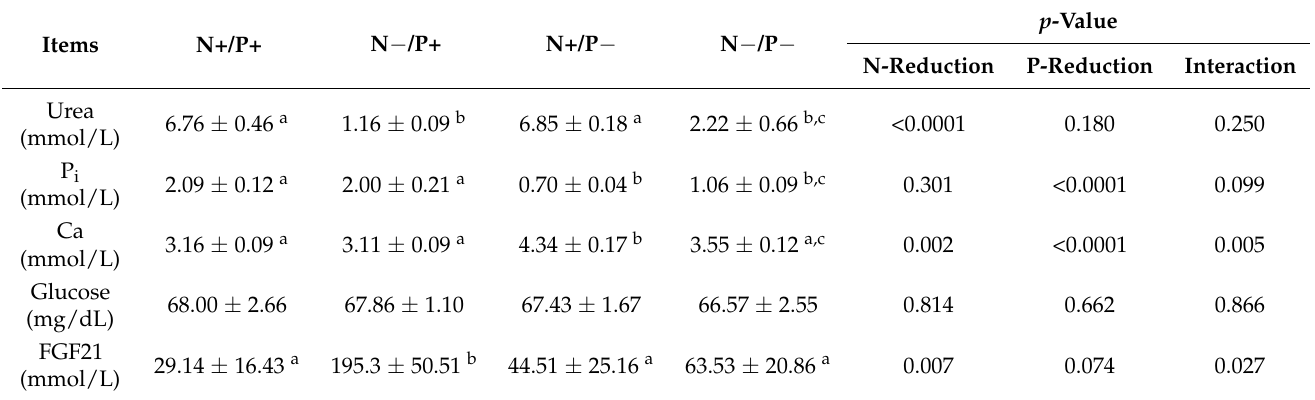
Table 3. Plasma concentration of urea, P i and Ca, concentration of FGF21 in serum, and glucose concentration in whole blood of young goats fed an N- and/or P-reduced